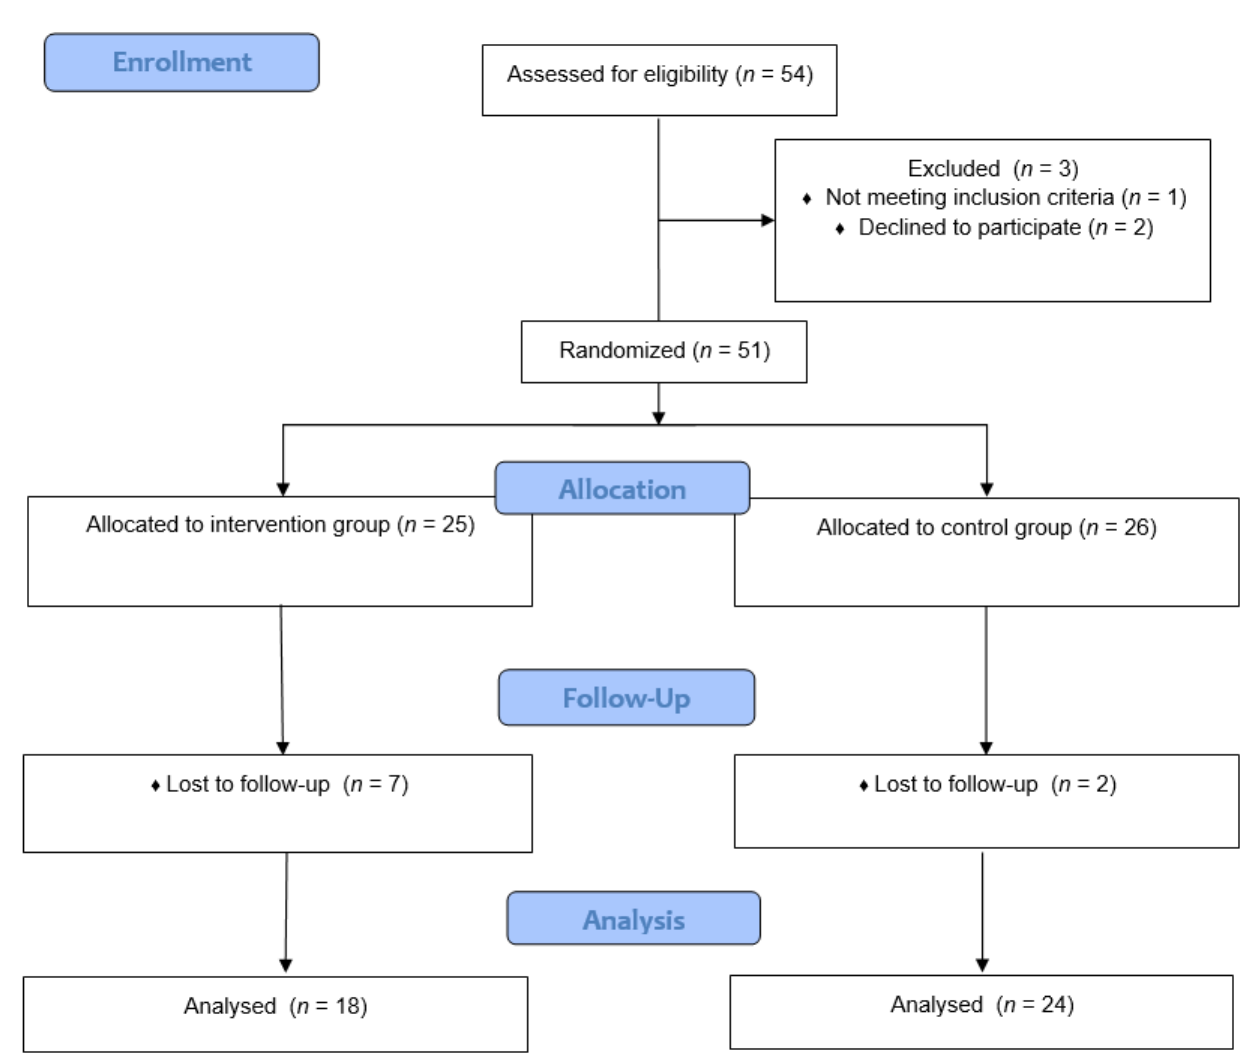
Figure 1. The flow of participants through the study.